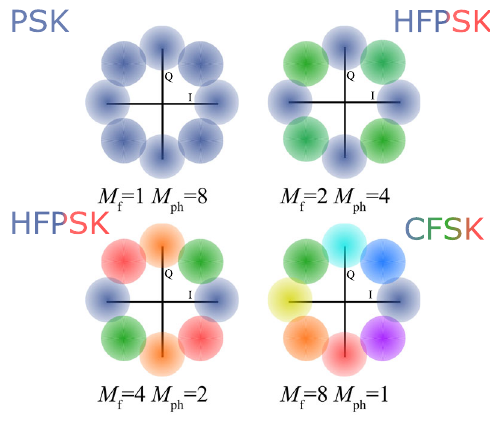
Fig. 1 Constellation diagrams of PSK, CFSK, and HFPSK for M = 8. Circles represent the symbols, the angle of the circle's center with respect to the horizontal axis represents the initial phase shift, and colors represent the frequency.